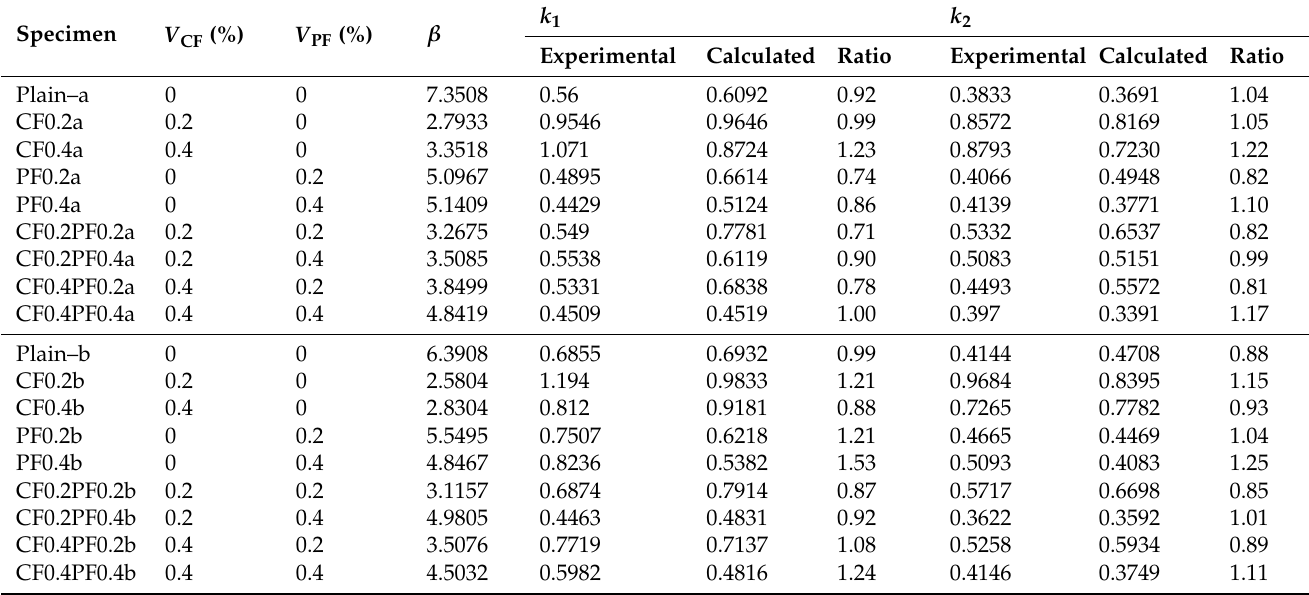
Table 9. Comparison of calculated values with the experimental